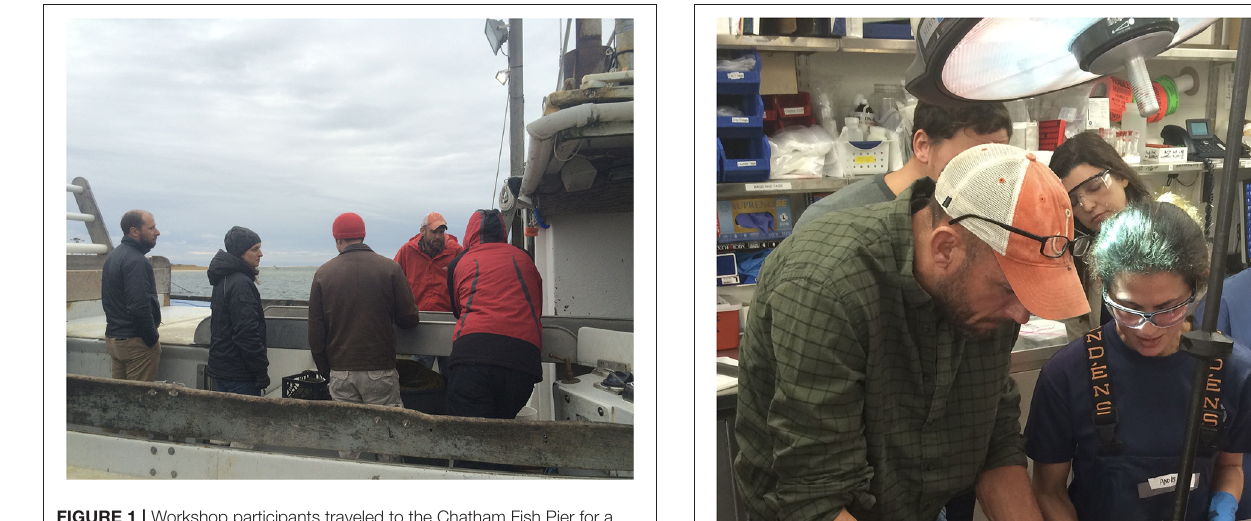
FIGURE 1 | Workshop participants traveled to the Chatham Fish Pier for a dockside examination and discussion on board two commercial fishing vessels, a demersal longliner or “tub trawler” (F/V Noah) and a gillnetter (F/V Dawn T). Here, a commercial fisherman explains the inner workings of a gillnet fishing boat to several marine mammal researchers and marine mammal stranding network personnel.